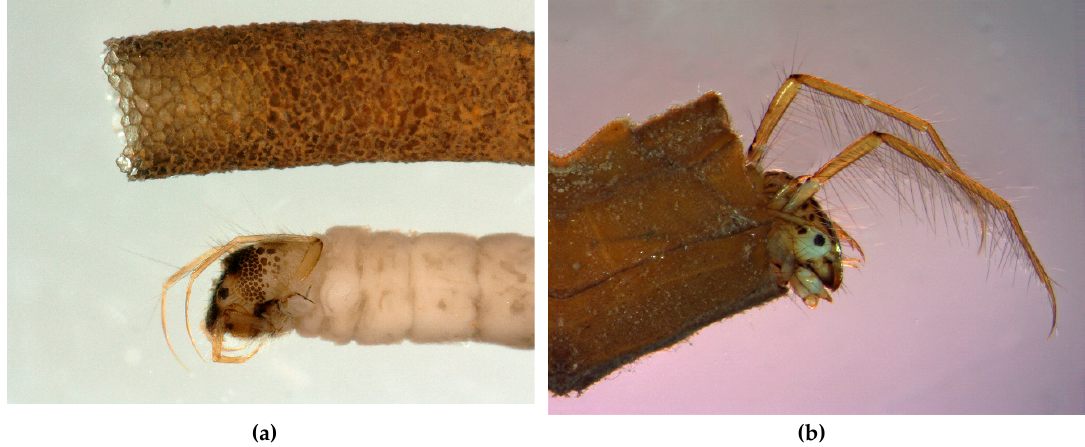
Figure 11. (a) : Larva of Beraeodes minutus (Linnaeus, 1761) (Brevitentoria: Beraeidae) and its case composed of fine sand. (b) : Larva of Triaenodes bicolor (Curtis, 1834) (Brevitentoria: Leptoceridae) in its case composed of pieces of angiosperm leaves. The rows of long hairs on the legs are used for swimming. Both figures © W. Graf.